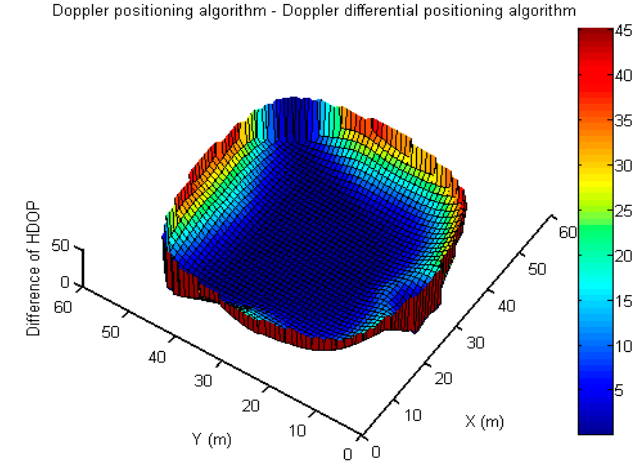
Figure 14. Di ff erence of HDOP between the Doppler positioning algorithm and Doppler di ff erential Figure 14. Difference of HDOP between the Doppler positioning algorithm and Doppler differential positioning algorithm. positioning algorithm. Table 8. Number of grids for the difference of HDOP (D_HDOP).